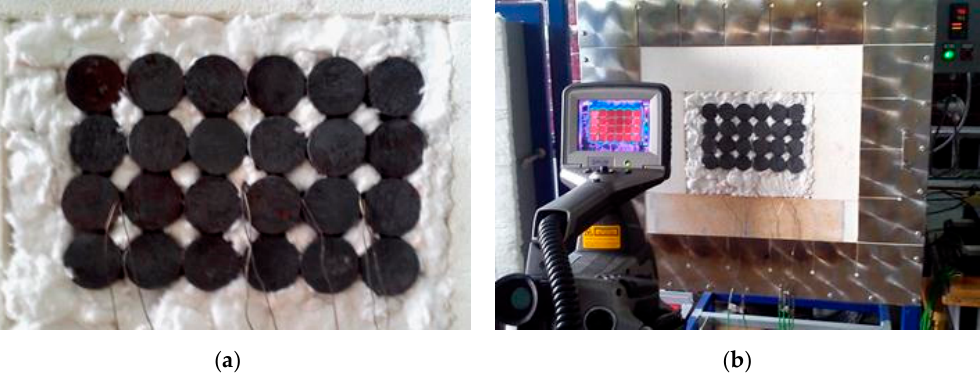
Figure 16. A bed of 40 mm bars in the electric furnace prepared for thermographic examinations: ( a ) view of the sample; ( b ) thermal camera recording the temperature of the heated charge.